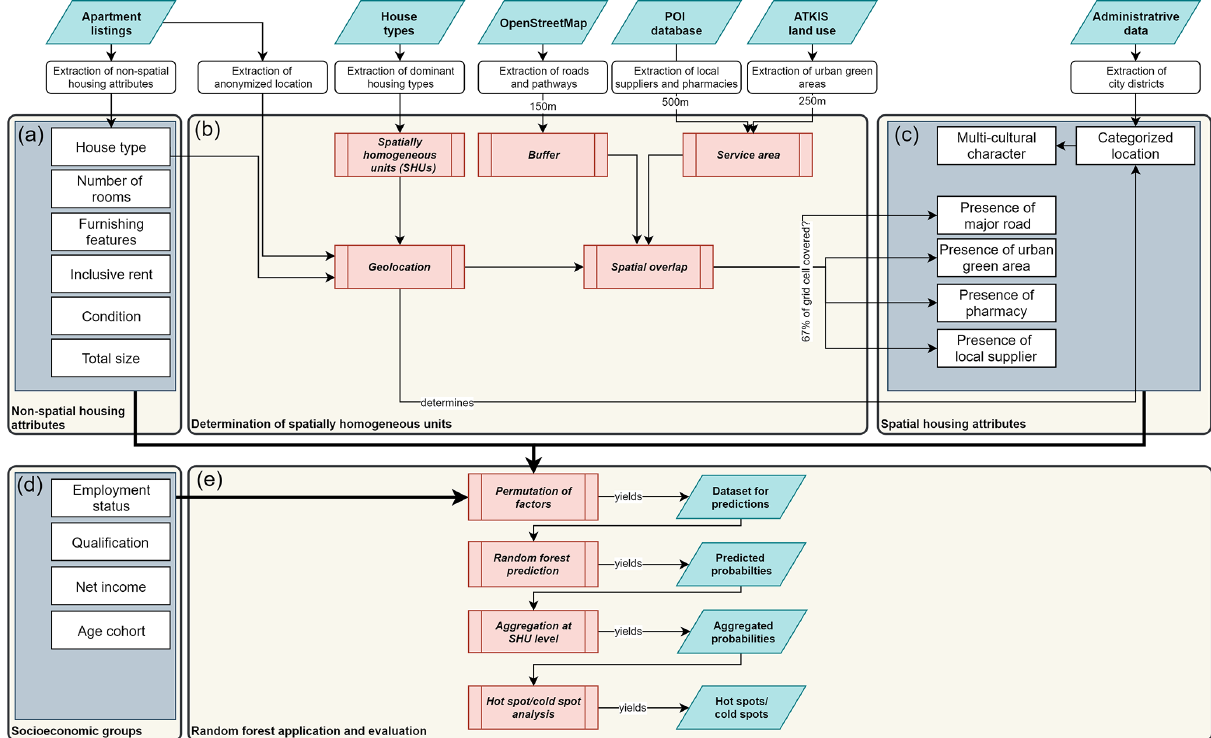
Figure 1. Data (pre-)processing for the prediction of residential-choice behaviour. (a) Non-spatial housing attributes are elicited directly from the apartment advertisements (Boelmann et al., 2019; see Table 1). (b) Identification of spatially homogeneous units and estimation of neighbourhood amenities per spatially homogeneous unit based on the spatial overlap of buffer and service areas of major roads, urban green areas, pharmacies, and local suppliers. Geolocation of advertised apartments within these spatially homogeneous units; (c) determination of spatial housing attributes as a function of the properties of the corresponding spatially homogeneous unit; (d) based on a set of formulated socioeconomic profiles, household attributes are created. (e) Permutation of predictor factors and subsequent application and evaluation of the random forest